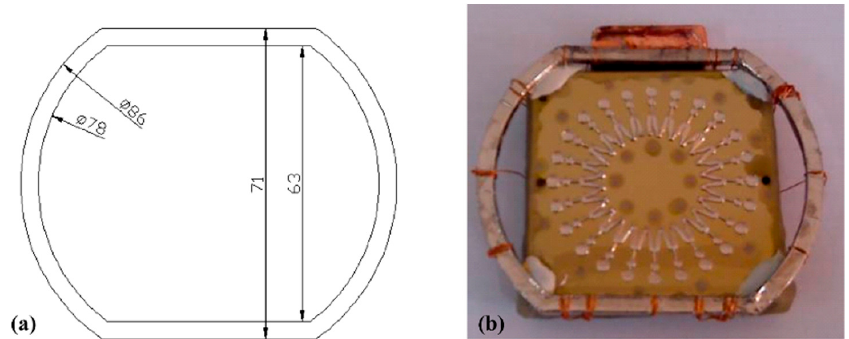
Figure 8. The second cathode: ( a ) design drawing; ( b ) physical prototype.